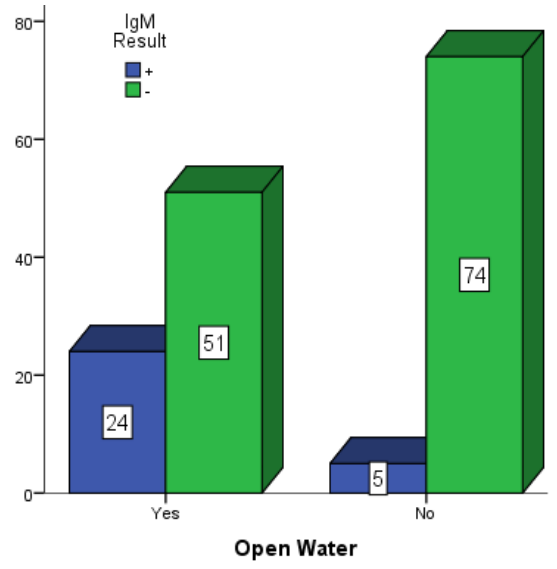
Figure 7. Participants with open water in their surroundings in Numan. DENV1 by Real-Time PCR assay and sequencing and grouped as genotype